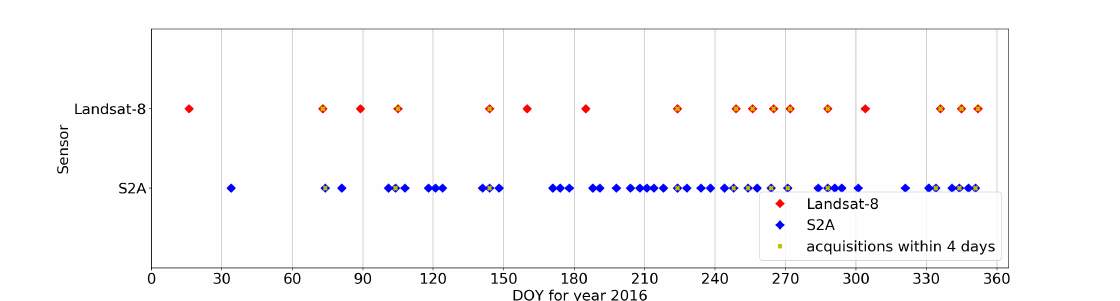
Figure 1. Acquisition dates in day of year (DOY) from Sentinel-2A and Landsat-8 for the year